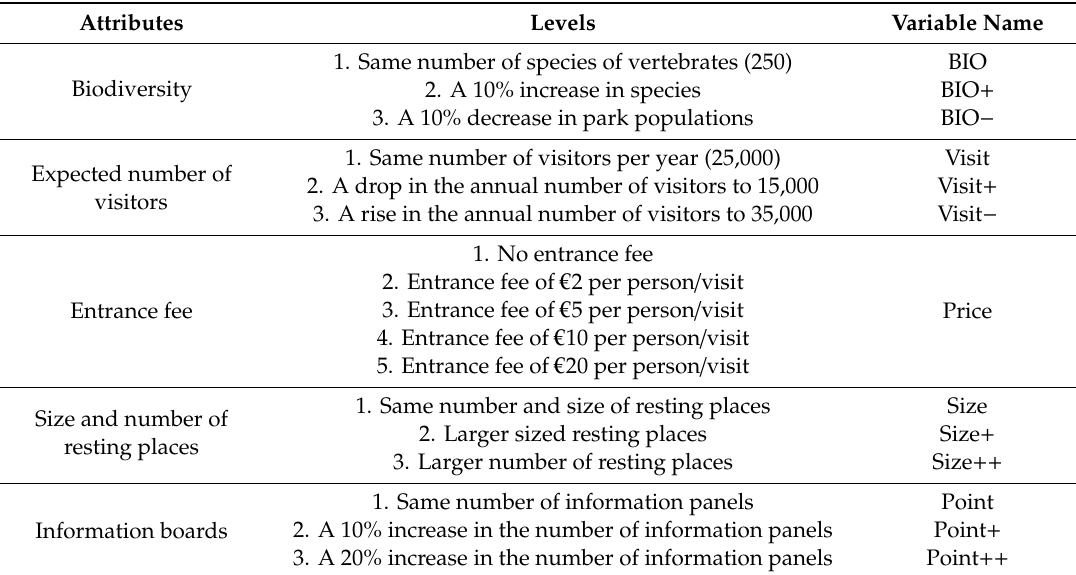
Table 2. Choice set attributes and attribute